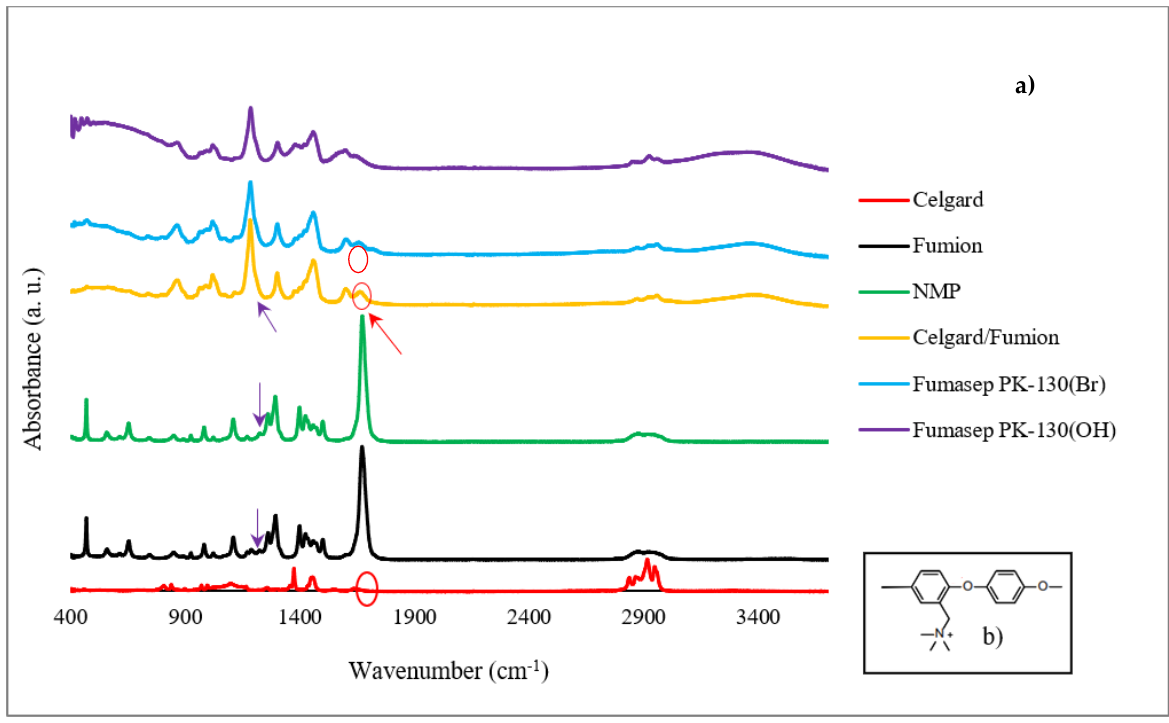
Figure 4. a) FTIR spectrum of the Celgard before and after activation, Fumion, Fumasep PK-130 (in Br − and OH − form), and NMP solvent, b) chemical structure of Fumion.